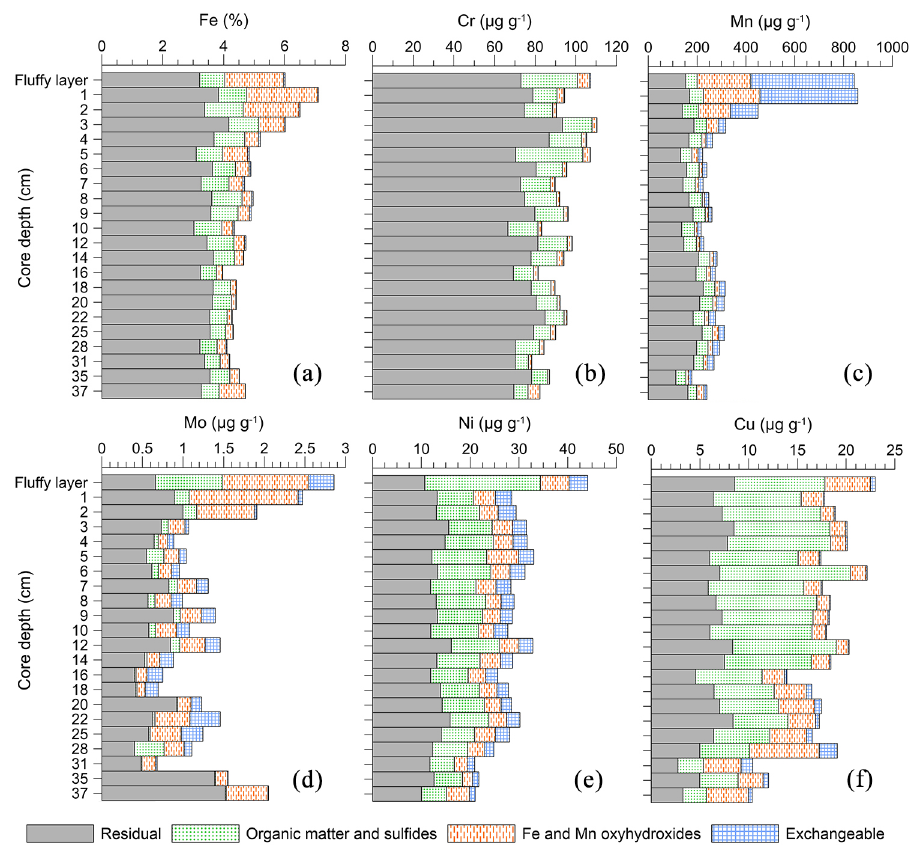
Figure 14. Downcore variation in the geochemical fractions of Fe ( a ), Cr ( b ), Mn ( c ), Mo ( d ), Ni ( e ), and Cu ( f ) in the AMK-5193 core, Central Deep of the Barents